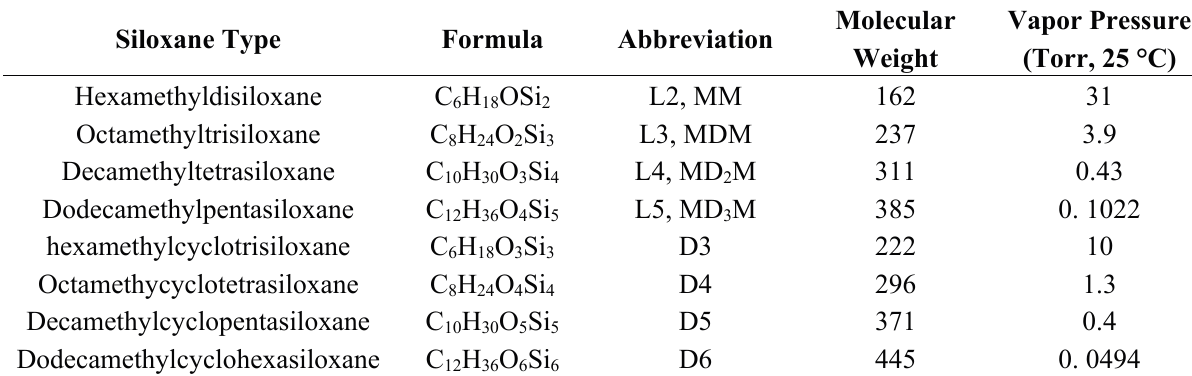
Table 3. Siloxanes and their physical properties.